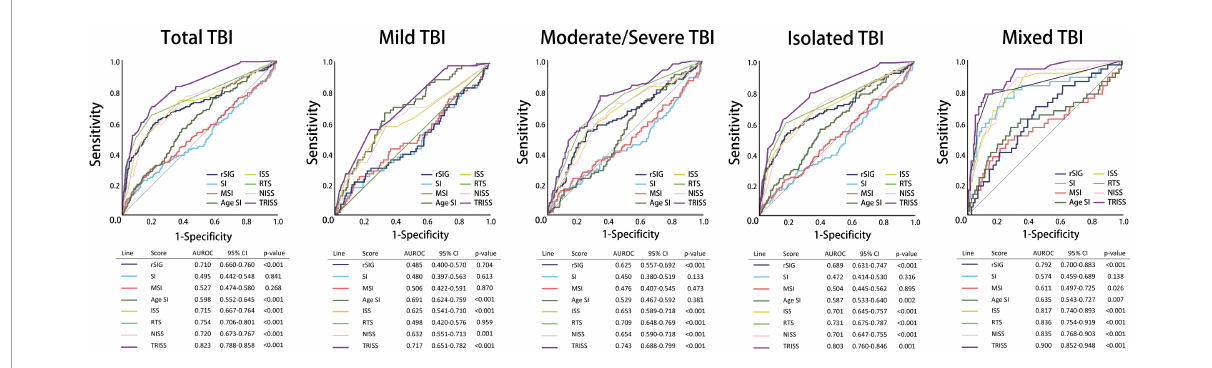
FIGURE5 Schematic diagram illustrating detailed AUROC in the subgroup analysis.